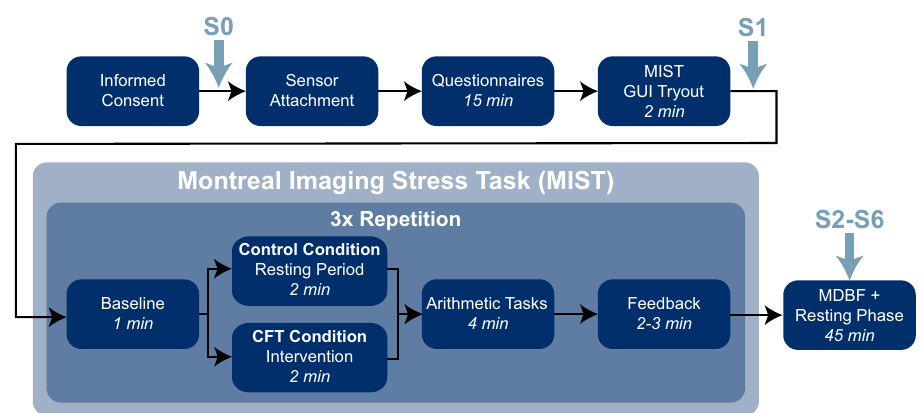
Figure 1. Overview of study protocol. The study consisted of a Preparation Phase , the Montreal Imaging Stress Task (MIST ), and a Resting Phase . S0–S6 indicate the time points at which saliva samples were